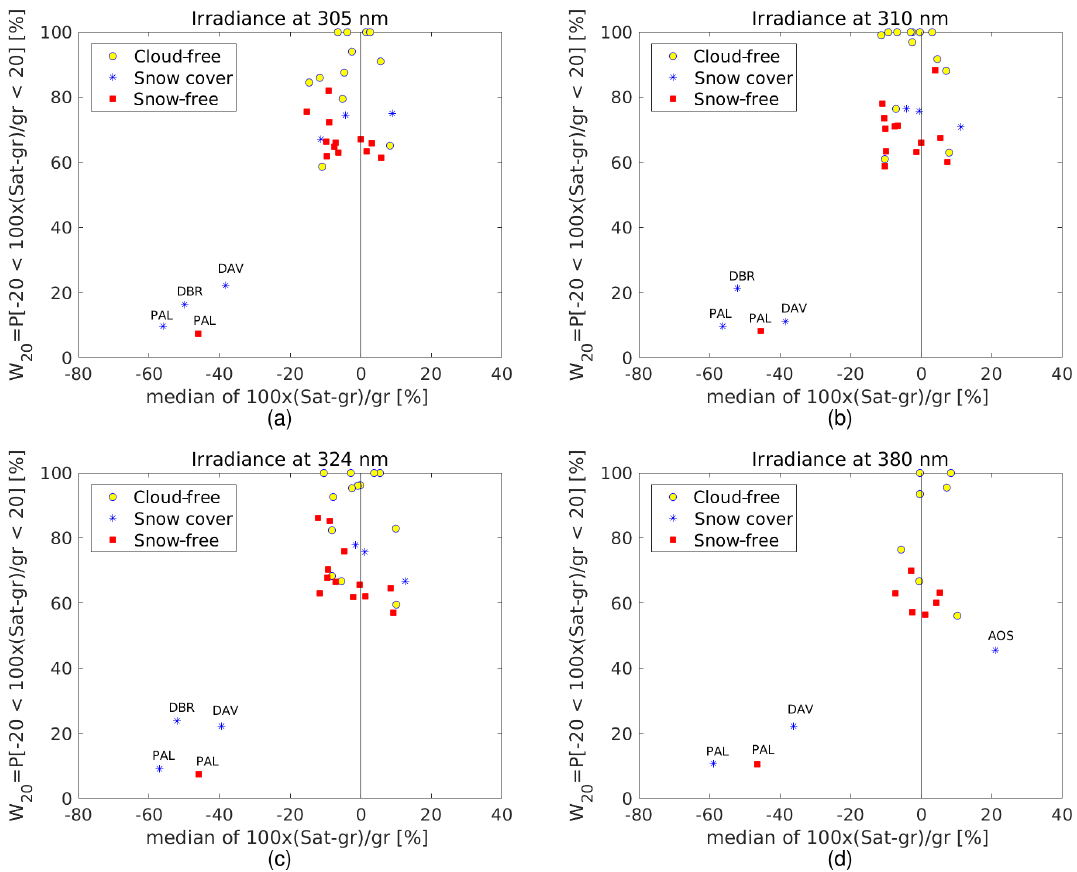
Figure 7. W 20 in function of ρ for validation sites measuring overpass irradiance at (a) 305, (b) 310, (c) 324 and (d)